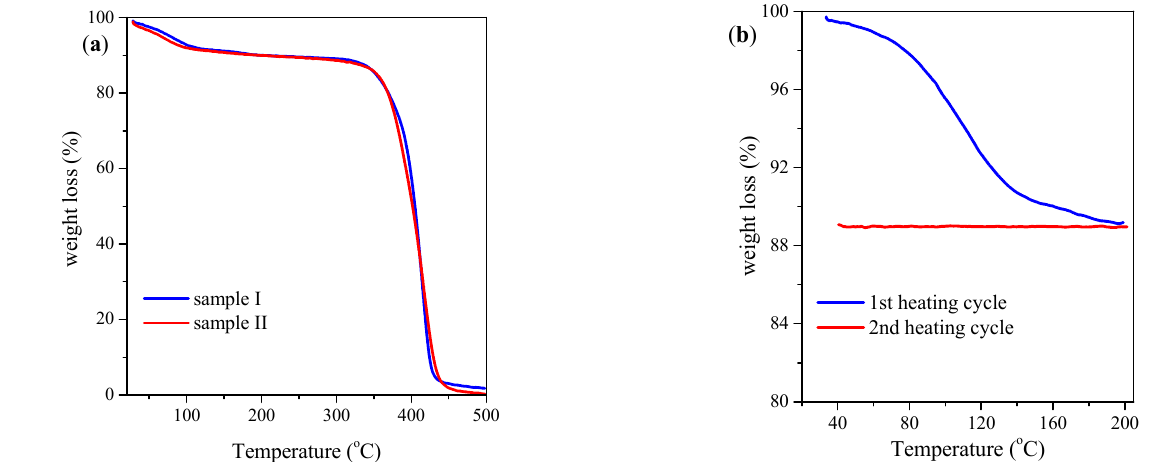
Figure A3. TGA curves of ( a ) sample I and sample II studies in this work and ( b ) sample II before and after annealing at 470 R for 15 min.